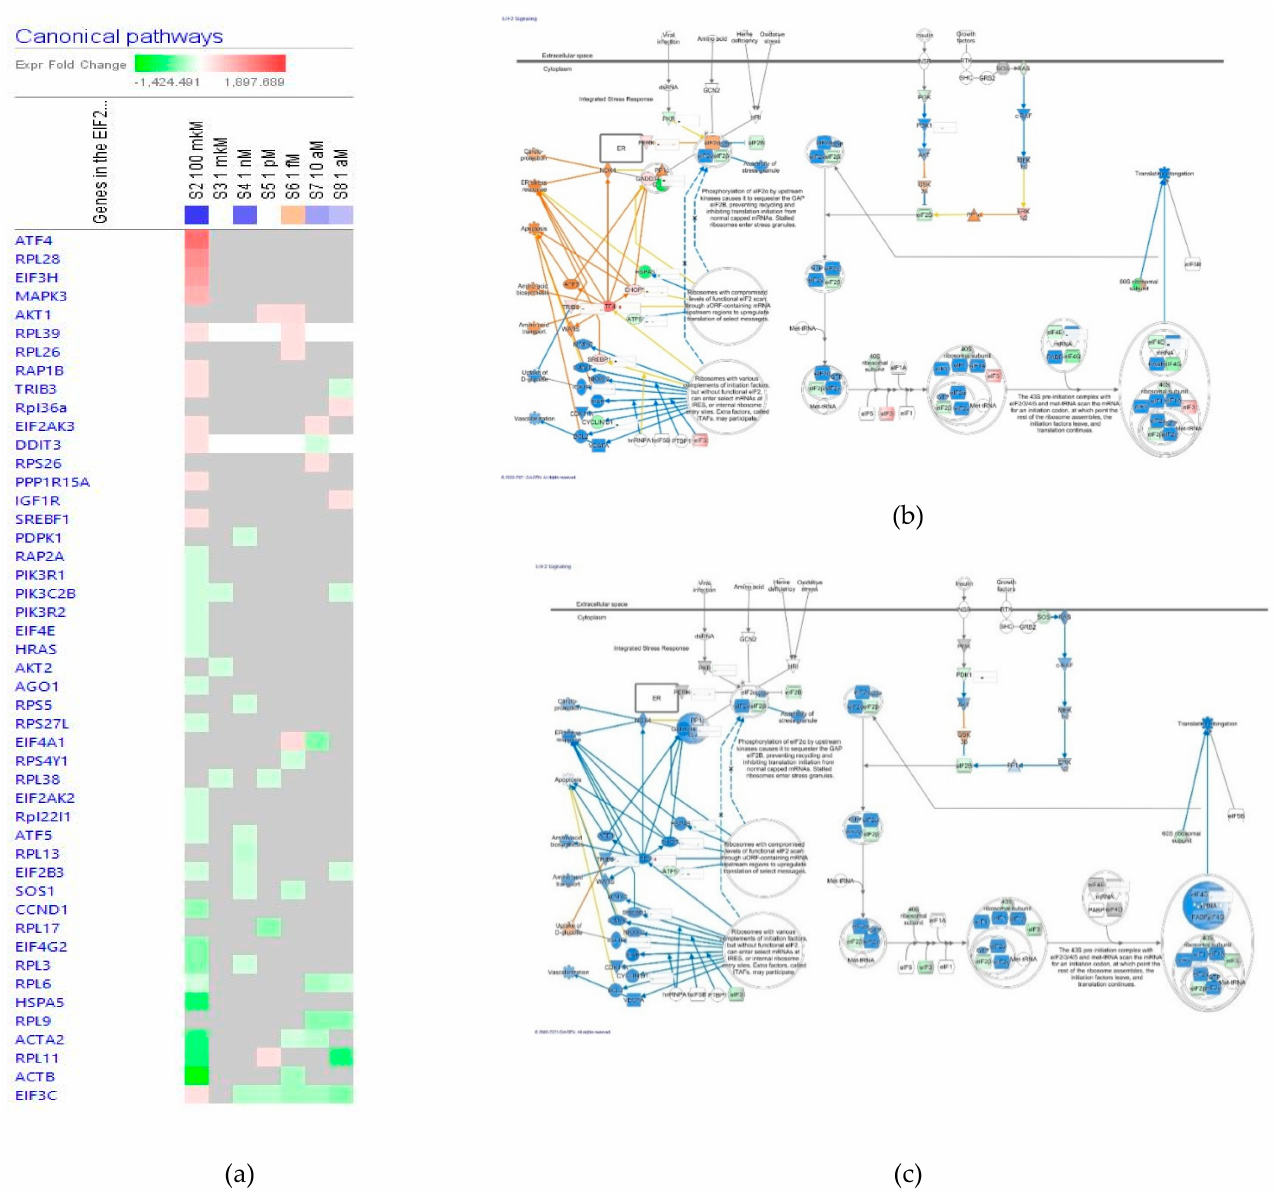
Figure 9. Effect of Rg5 on EIF2 signaling pathway: ( a ) Heatmap of gene expression (in fold changes compared to control, red, upregulation and green, downregulation), after exposure with ginsenoside Rg5 in different concentrations; the 100 µ M signature is shown in the leftmost column as solid red or green squares indicating genes that are upregulated or downregulated, respectively; color intensity indicates the actual log-fold changes; ( b ) Rg5 at a concentration of 100 µ M— predicted inhibition (blue) and activation (brown); ( c ) Rg5 at a concentration of 1 µ M—predicted inhibition (blue) and activation